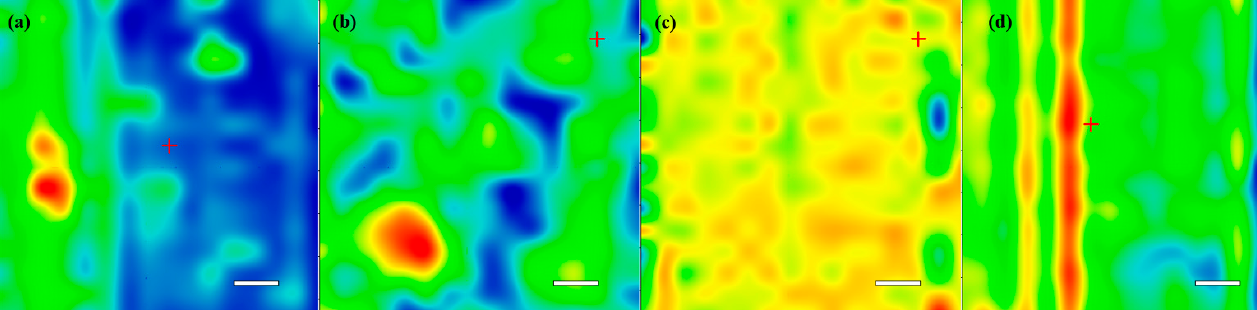
Figure 6. IRM of Fe 3 O 4 @CS/LyZ drop-cast ( a ) and Fe 3 O 4 @CS/LyZ thin coatings at 300 mJ/cm 2 ( b ), 400 mJ/cm 2 ( c ), and 500 mJ/cm 2 ( d ) based on the distribution of C-N bonds from CS and LyZ; scale bar 100µm.